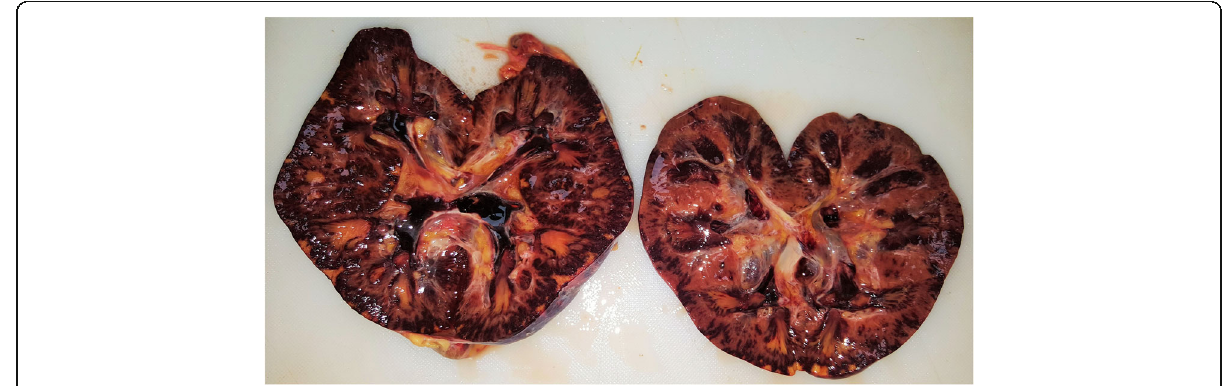
Fig. 1 Cut surface of kidneys showing medullary